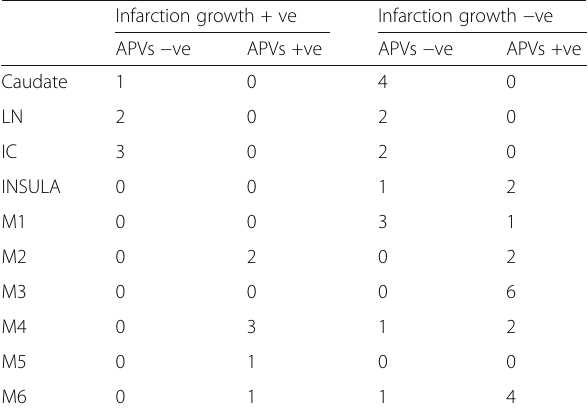
Table 4 Distribution of APVs and presence or absence of infarct growth in the MCA territories in the IG group